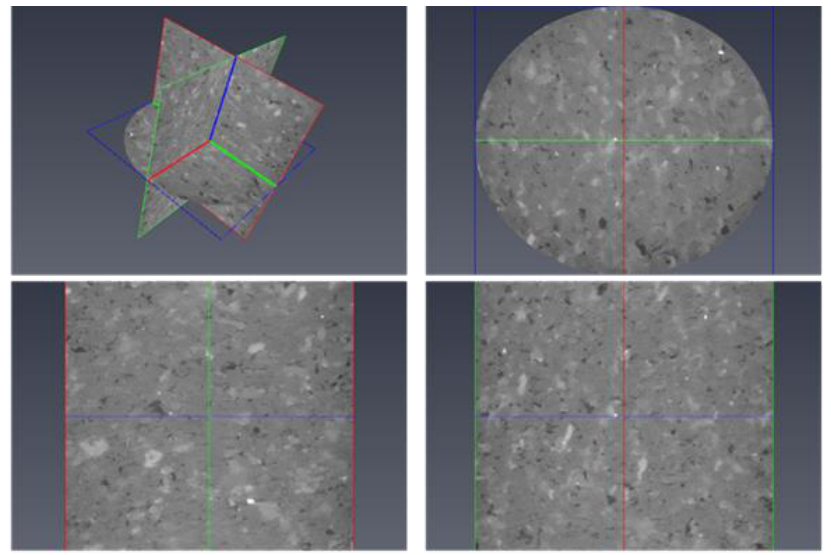
Figure 3. Three-dimensional slice of the pores and mineral skeleton of the initial dry sample (gray map).